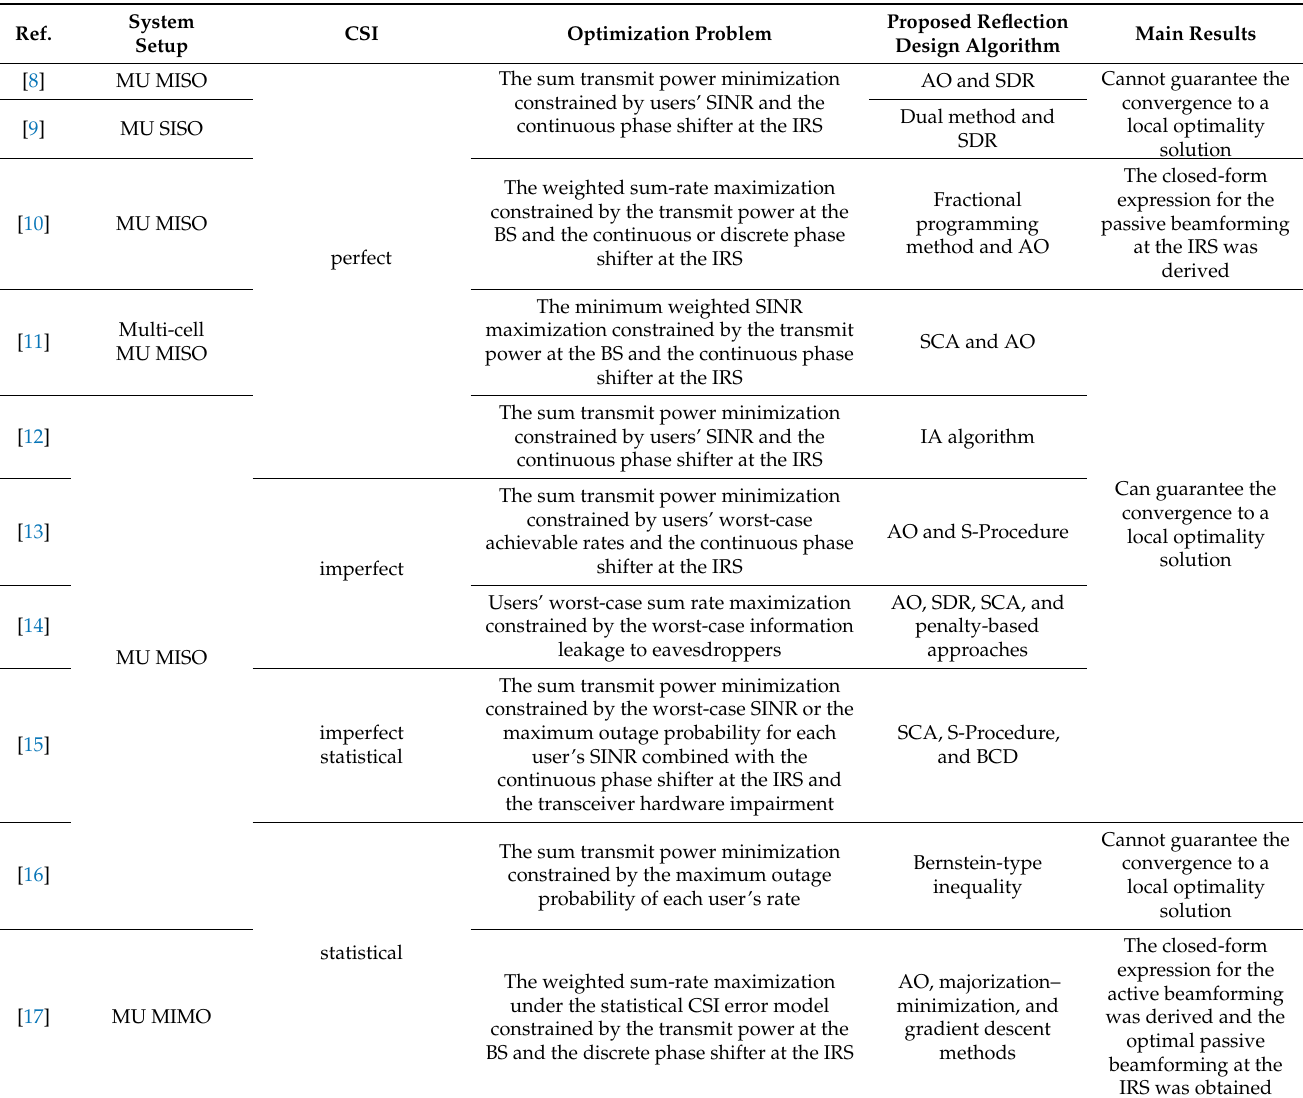
Table 1. A summary of different performance analyses for IRS-assisted wireless communication